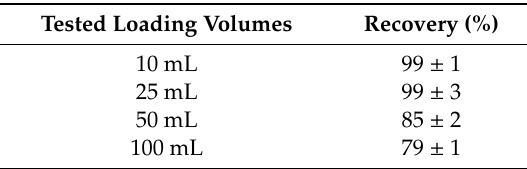
Table 6. Recovery percentage of PTA with different loading volumes (n = 2) of MilliQ spiked water samples OASIS MAX column (60 mg).